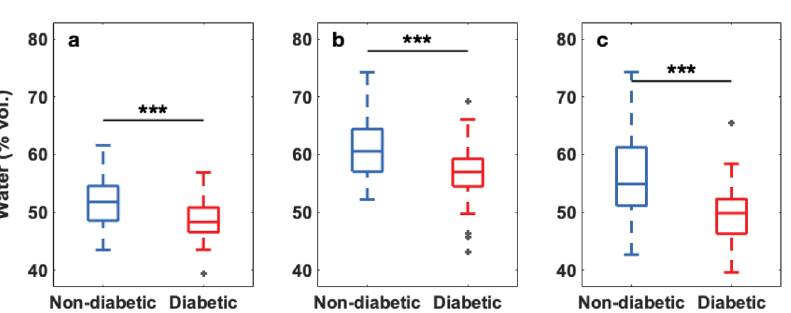
Figure 2. Average foot sole hydration evolution with age on ( a ) all non-diabetic subjects (red circles, n = 98 ) and non-diabetic subjects above 40 years old (blue diamonds, n = 83 ). ( b ) Diabetic subjects above 40 years old ( n = 80 ). ( c ) Average foot sole hydration evolution as function of the time since diagnosis of diabetes. Linear fits to the data and confidence intervals are represented by solid lines and shaded areas, respectively.